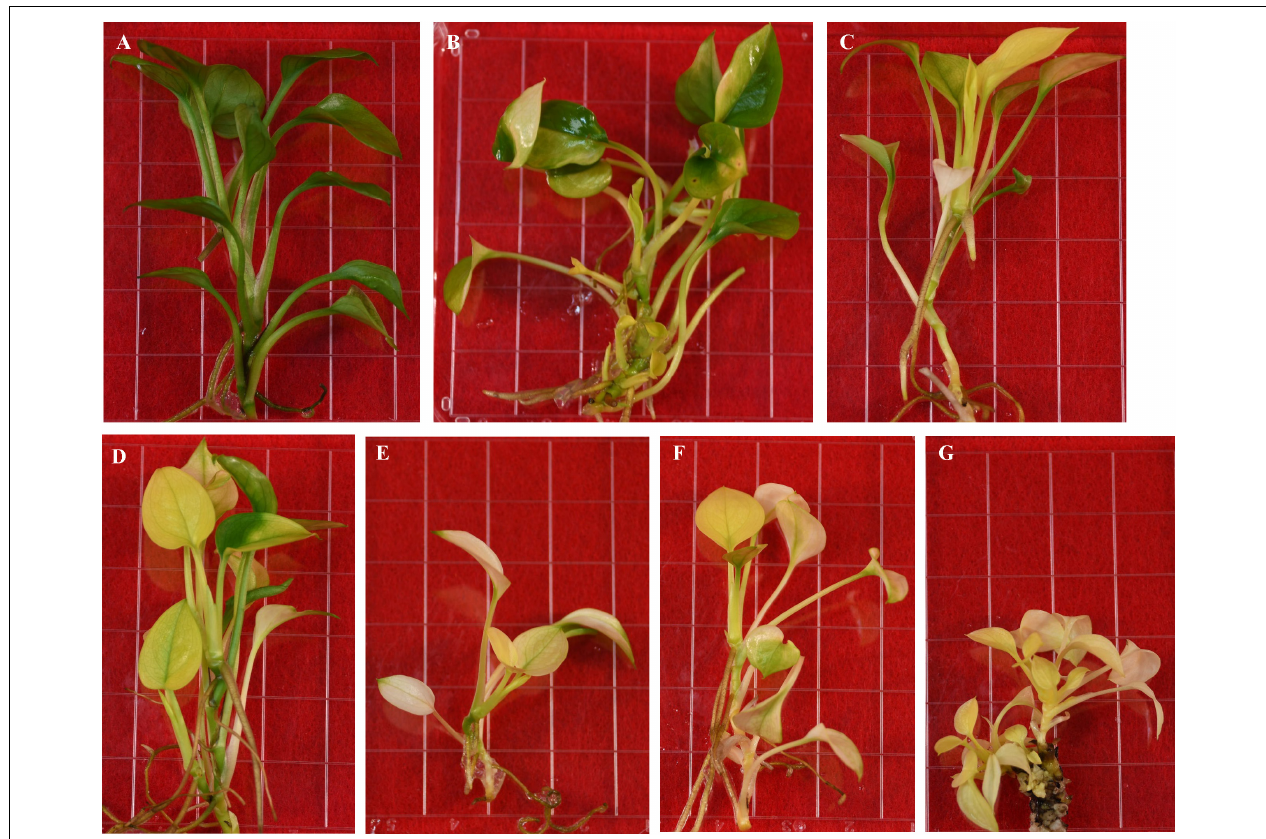
FIGURE 5 | Regenerated transgenic plants from the same transformed callus expressing Arabidopsis CHL27 . (A) Pure green. (B–D) Variegated. (E–G) Pale